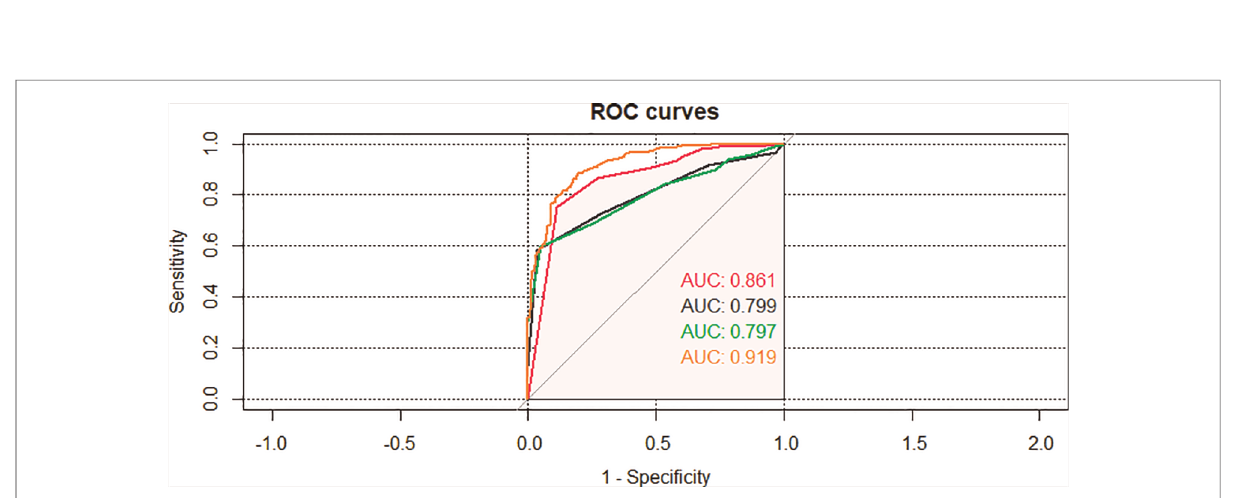
FIGURE 7 Area under the curve (AUC) of comparison of the nomogram and the three critical scores in the validating